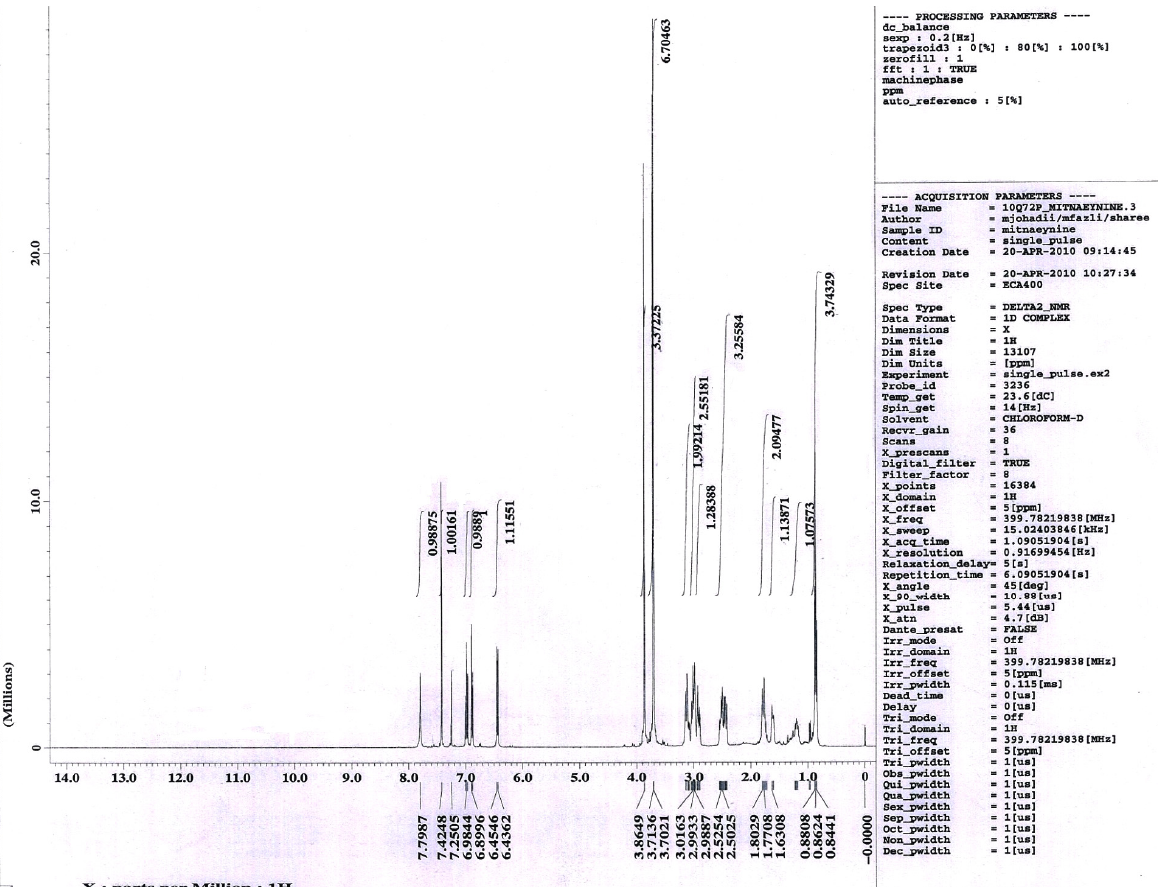
Figure 2. 1 H NMR chromatogram of mitragynine from Mitragyna speciosa leaves in deuterium chloroform.